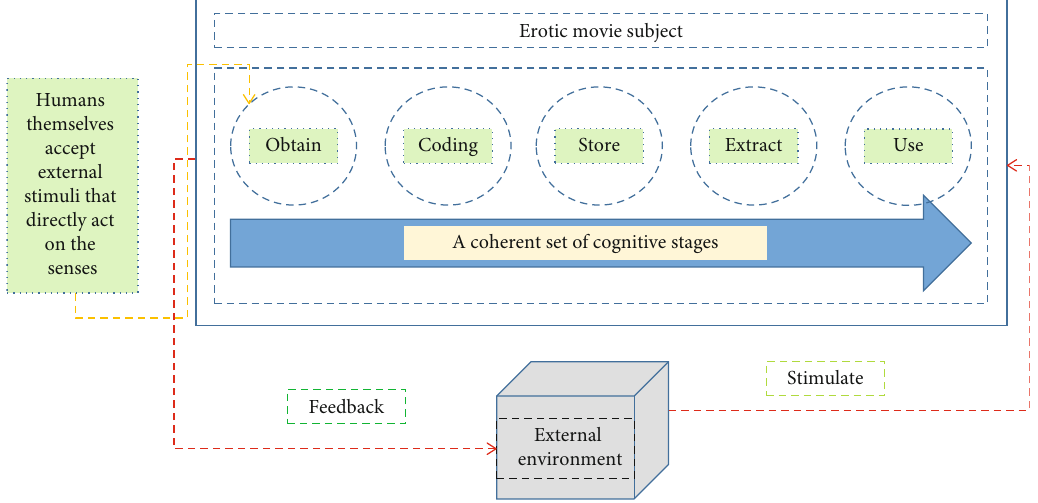
Figure 1: The cognitive process of the subject of erotic